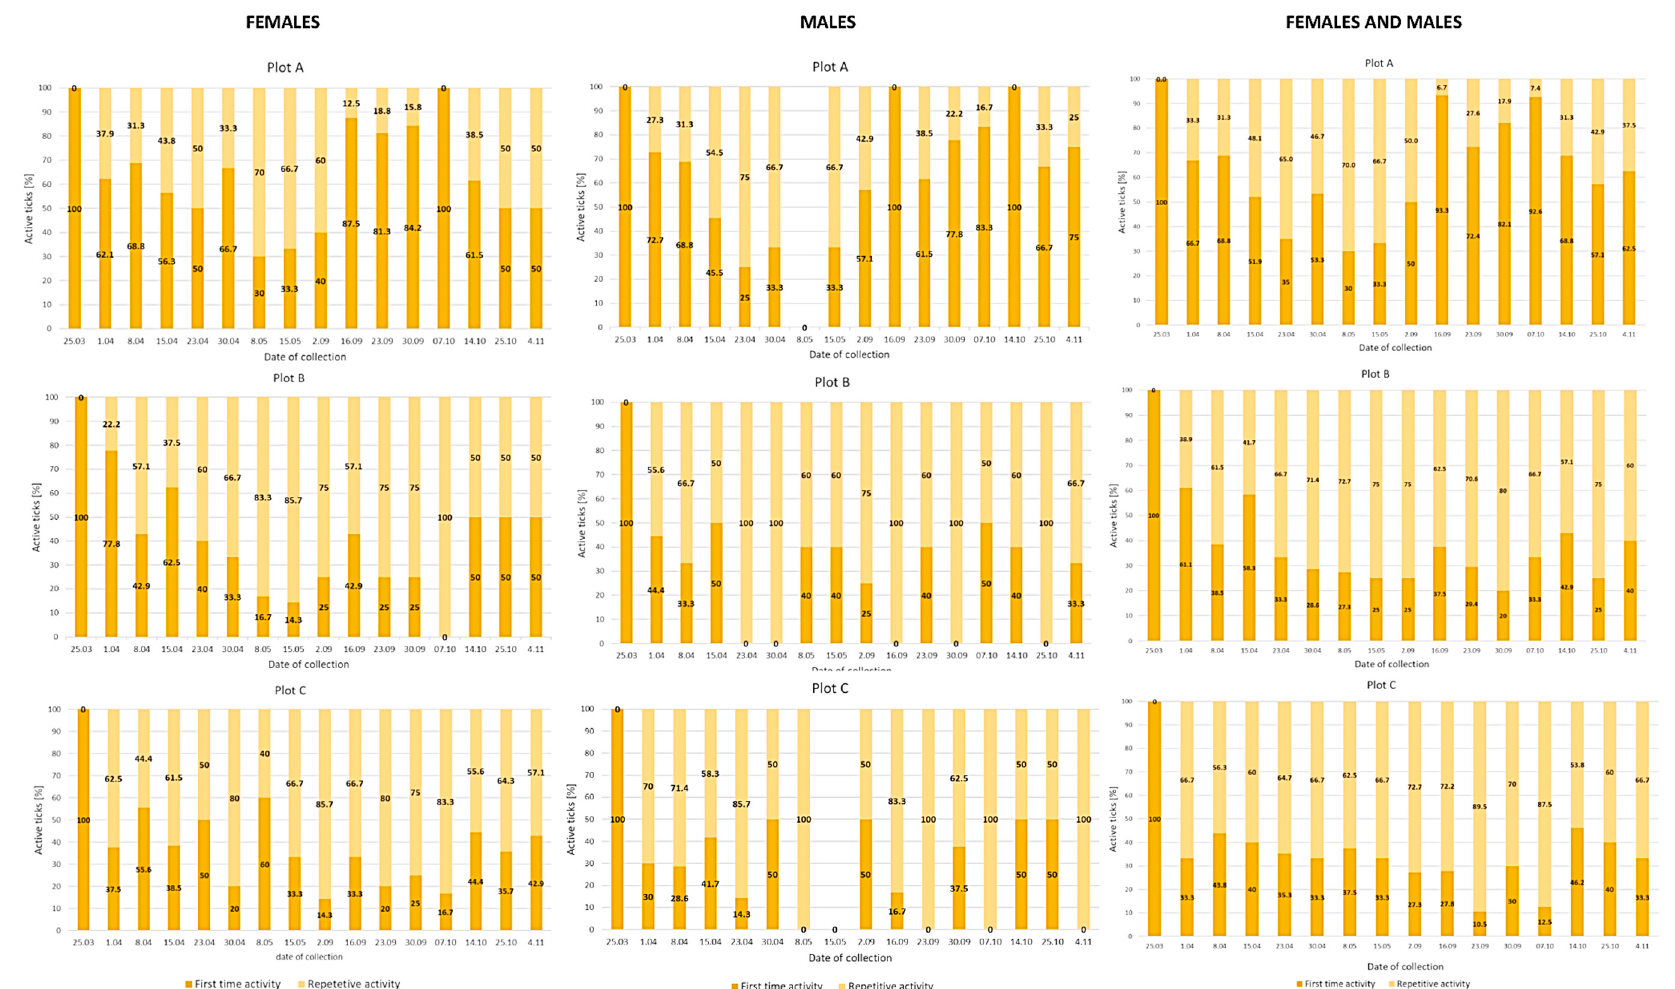
Figure A1. Seasonal distribution of repetitive activity of Dermacentor reticulatus adults in particular localities in eastern Poland (2019 ).